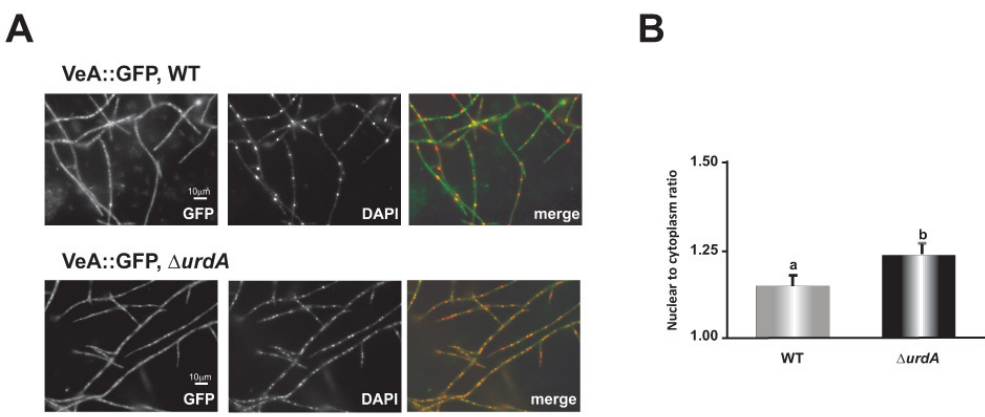
Figure 8. urdA influences accumulation and location of VeA in fungal cells. A. nidulans wild type (WT) and a ∆ urdA strain containing a veA ::gfp:: pyrG cassette were cultured in the dark for 6 h and then shifted to light. ( A ) Micrographs showing green fluorescence, DAPI stained nuclei, and merged images. ( B ) Nuclear to cytoplasmic ratio of the fluorescence in each compartments were calculated using the pixel intensity values. The mean were taken from 40 measurements at different nuclear and cytoplasmic compartments. Different letters above the bar graphs represent significantly different values ( p ≤ 0.05).